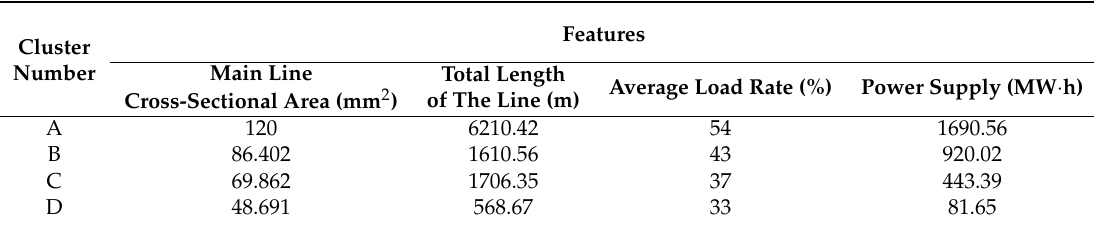
Table 1. Cluster center of each